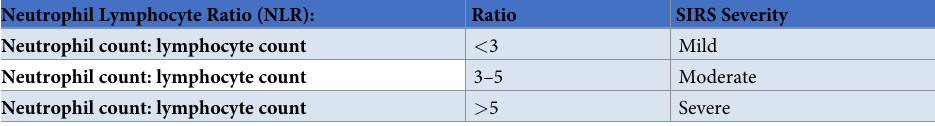
Table 2. Calculation of the neutrophil lymphocyte ratio (NLR).